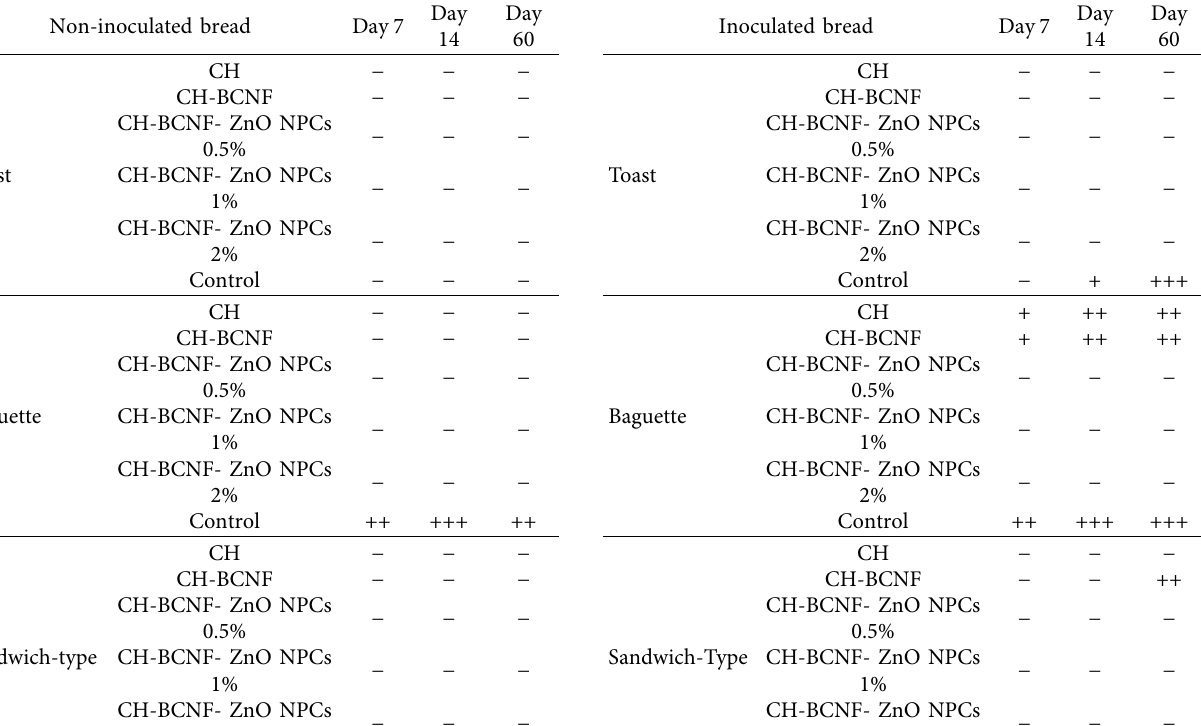
Table 7: Visual observation of mold growth in inoculated bread with Aspergillus niger at 25 °